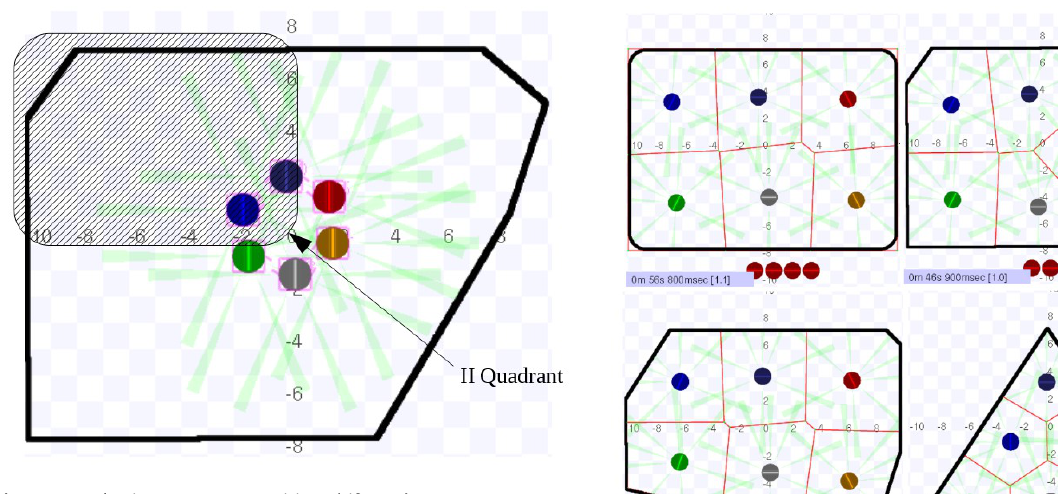
Figure 11: Robotic group start position shift study setup.